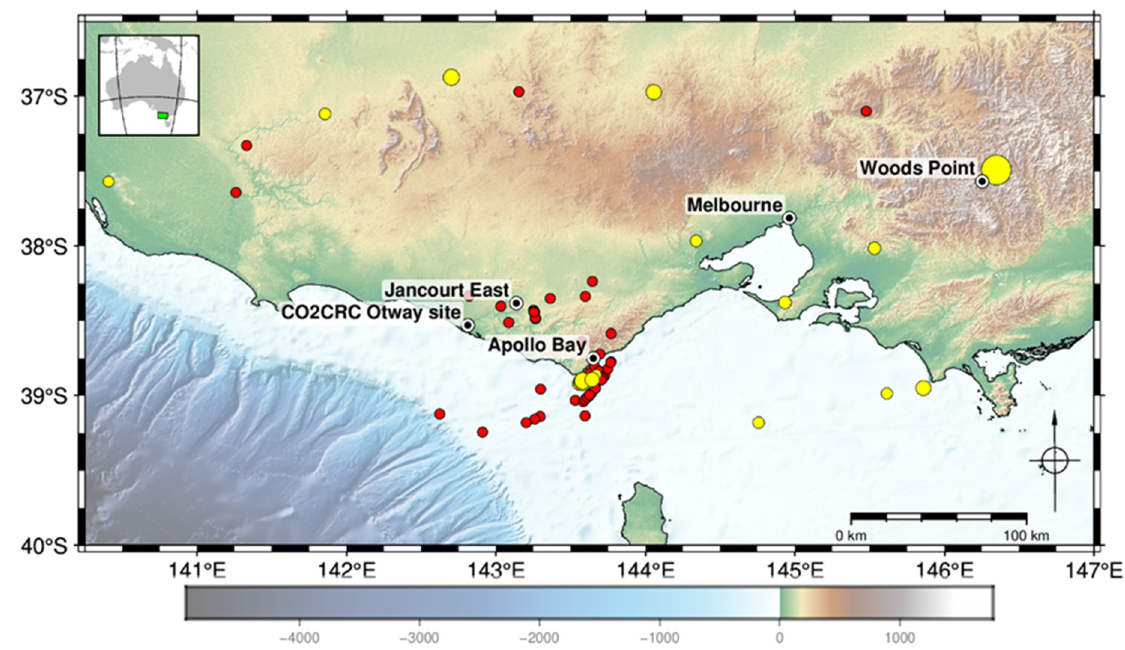
Figure 4. Located earthquake epicentres (red) and event epicentres from catalogue (yellow).